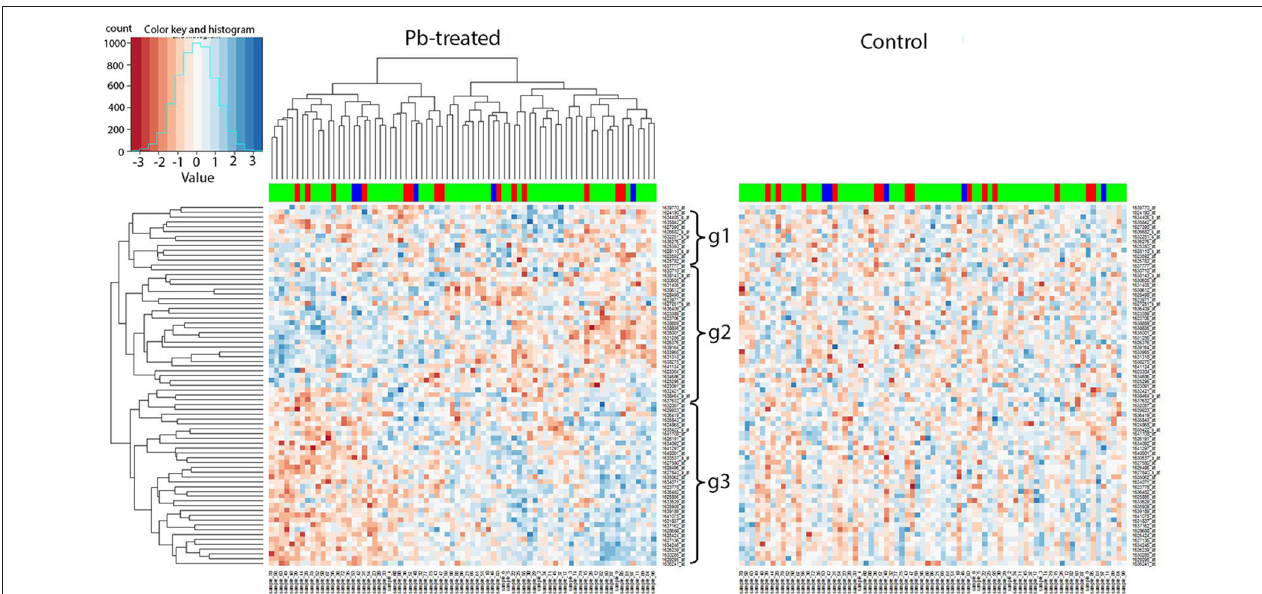
FIGURE 6 | Trans- eQTL hotspot at 27E (nearest to Chr 2L: 6,250,000). Expression levels of candidate downstream genes detected with RNA-seq were extracted from the microarray data and hierarchical clustering analysis was done afterwards. In the left panel (lead-treated), genes could be roughly divided into three groups g1, g2, and g3. Most genes from g1 and g3 belong to G1 from the RNA-seq data, while most genes from g2 were the same as G2. The right heatmap was created by keeping the order of the sample names and associated gene names in the lead-treated plot on the right but replacing with the control expression data. The expression patterns formed in lead-treated data disappeared in control data, suggesting the genes forming expression patterns could only be observed in expression levels after lead exposure. The color-coded bar above the heatmap and below the dendrogram indicates the original parent of each sample listed at the bottom at this specific location. Color legend in the color-coded bar: red: Oregon R (ORE), green: Russian 2B (2B), blue: heterozygous. No segregation based on the parental origin was seen, suggesting these two parental lines do not differ in expression levels and this also explains why this has not been detected as a trans- eQTL hotspot in the microarray